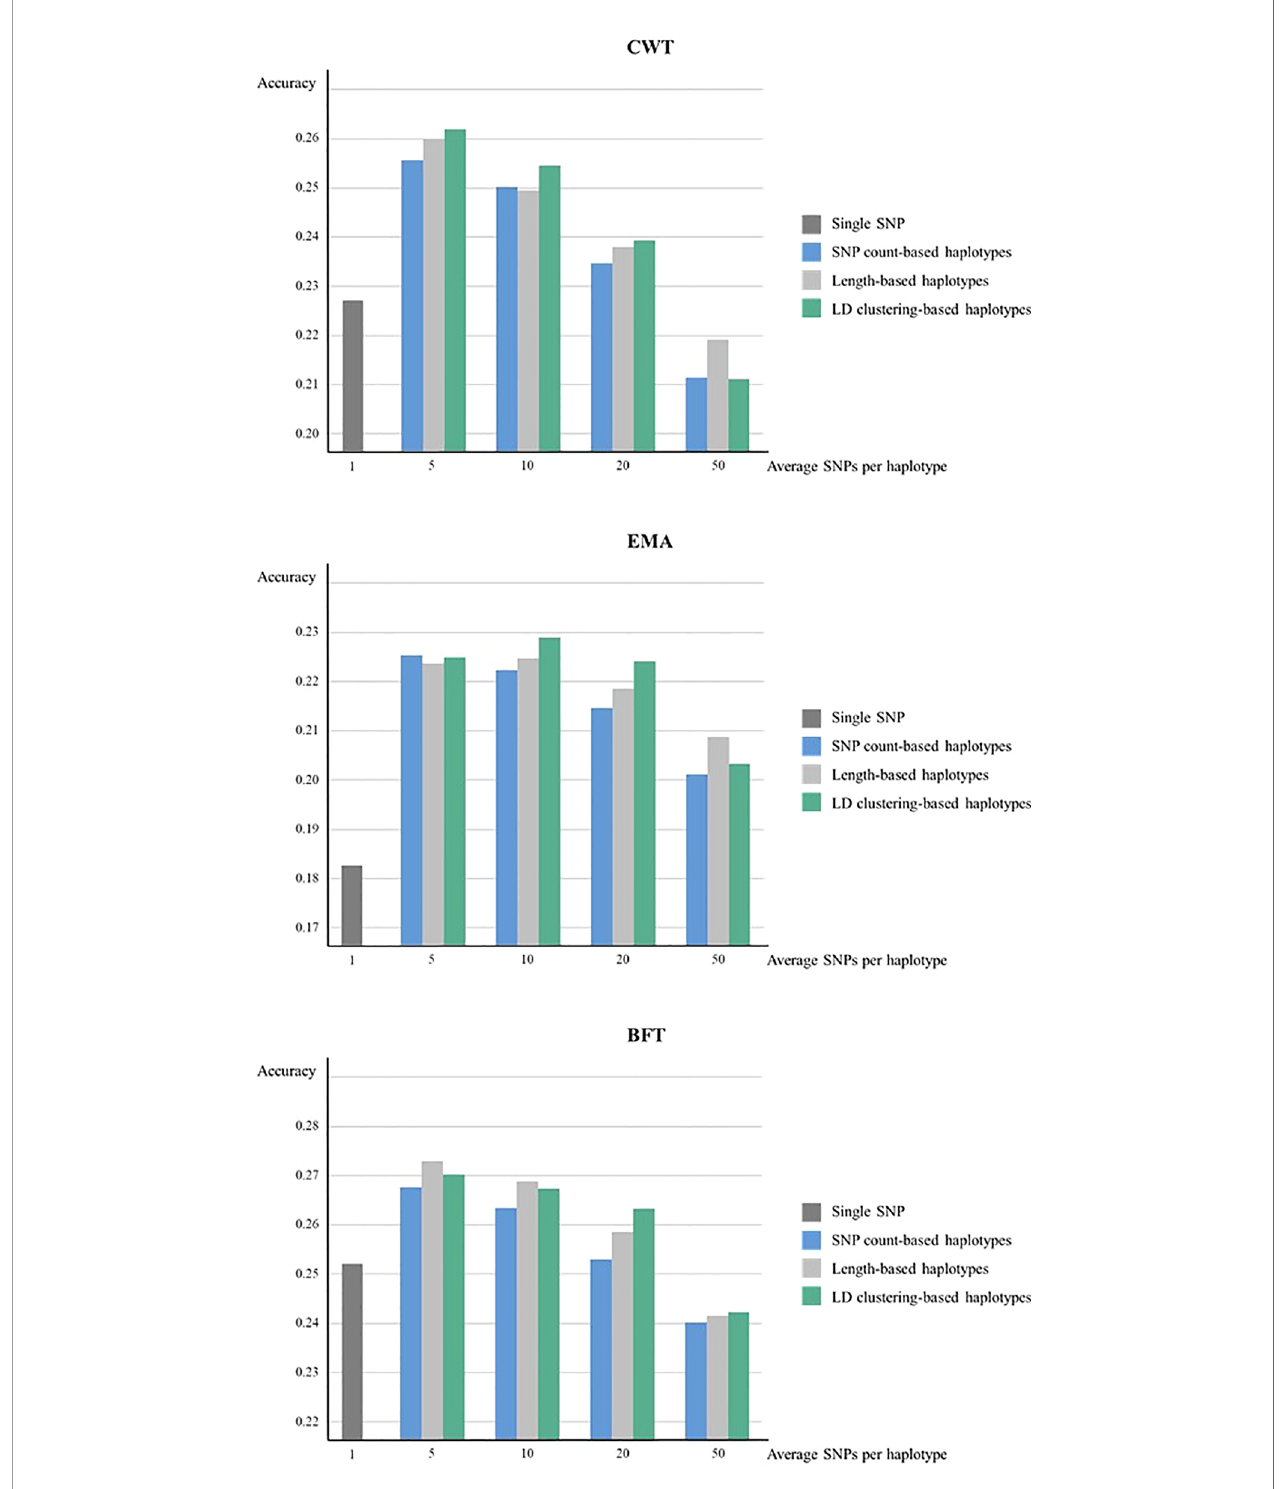
FIGURE 2 | Genomic prediction accuracies from forward validation. Prediction accuracies of using various sizes of haplotypes de fi ned by different methods and using individual SNPs were compared for CWT, BFT and EMA respectively. Accuracies were calculated as the correlation coef fi cients of GEBVs and pre-corrected